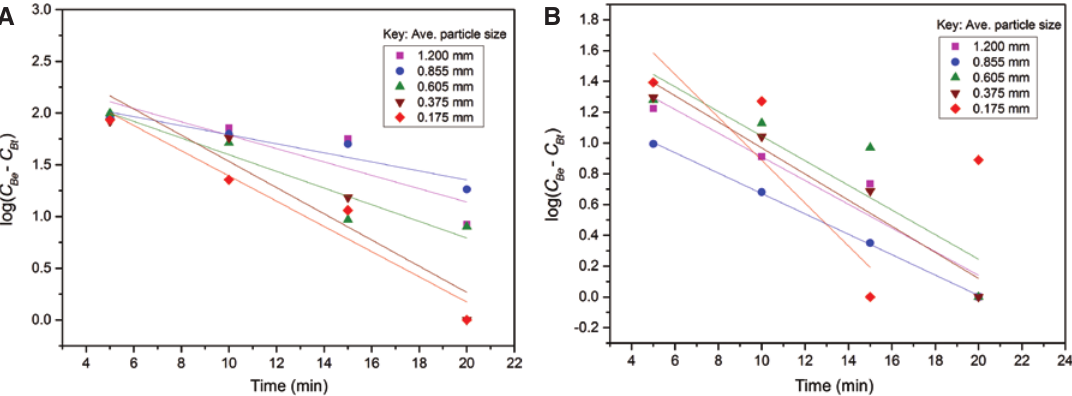
Figure 10: First-order kinetic model testing for the green solid-liquid extraction of andrographolide from Andrographis paniculata (AP) at 80 ° C for different particle sizes and solid-liquid ratios of (A) 1:10 (g ml -1 ) and (B) 1:50 (g ml -1 ).